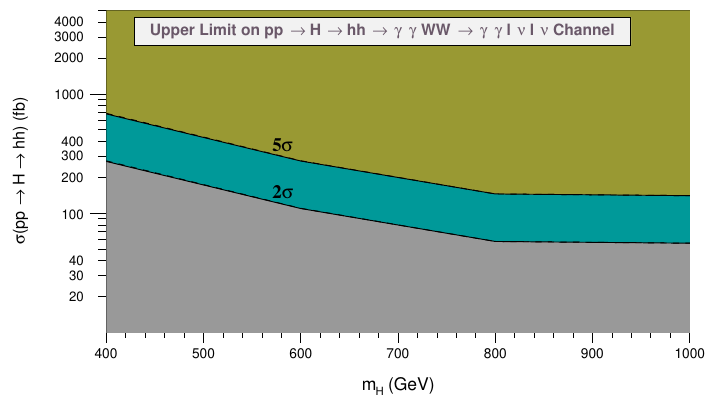
Figure 27 . Upper limit on (cid:27) ( pp channel. The solid (dashed) lines show the 2 (cid:27) -5 (cid:27) band on taking 0% (5%) systematic uncertainties.